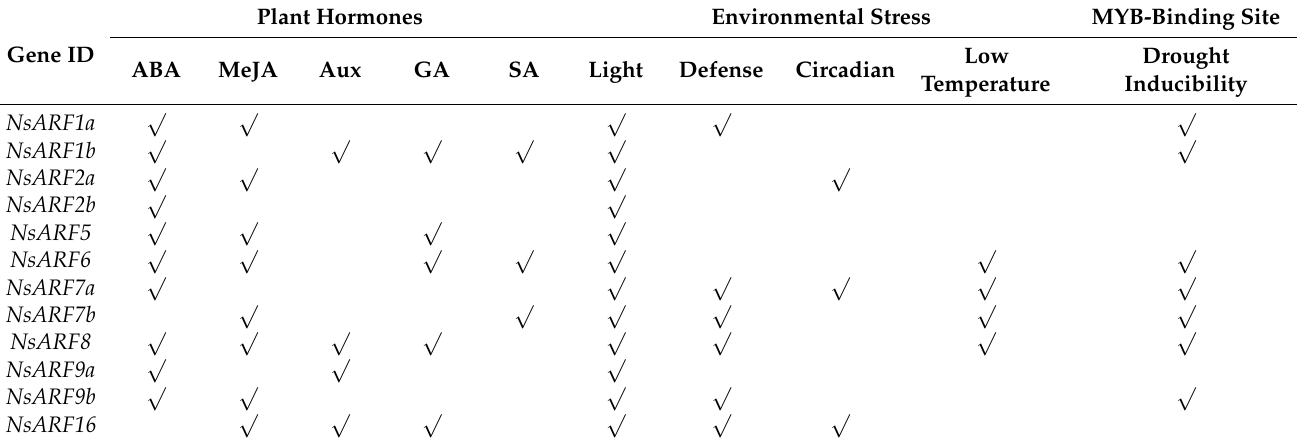
Figure 4. ( A ): Cis-acting element analysis of ARF gene in Nitraria sibirica . ( B ): Summary of cis-acting elements’ number and function of ARF gene in Nitraria sibirica . Table 3. NsARF promoter cis-element analysis.